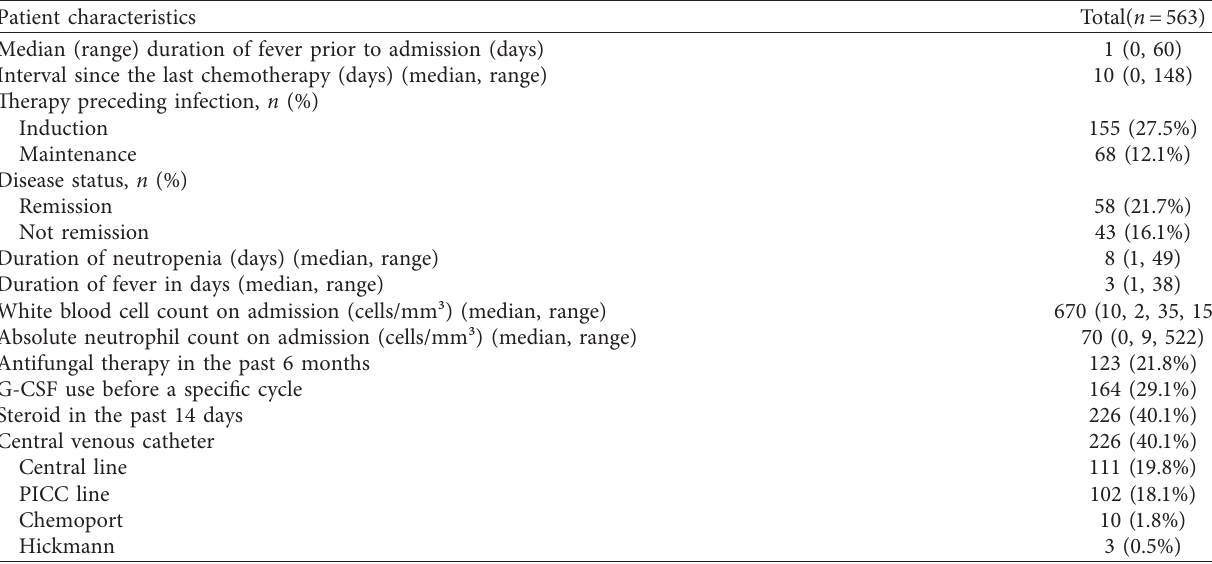
Table 2: Characteristics of 563 febrile neutropenia